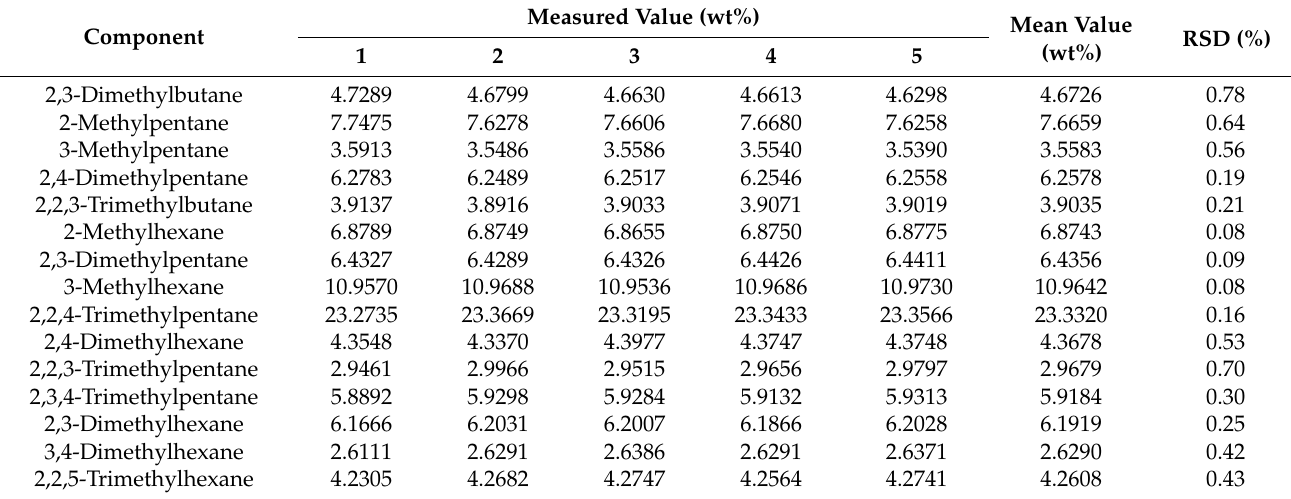
Table 3. Precision measurement results.